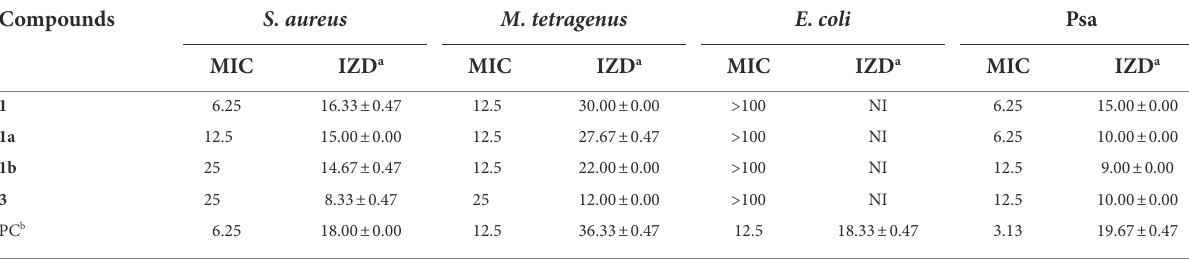
TABLE 2 Minimum inhibitory concentration (MIC) values ( μ g/mL) and inhibition zone diameter (IZD, mm) of compounds against four tested bacteria.